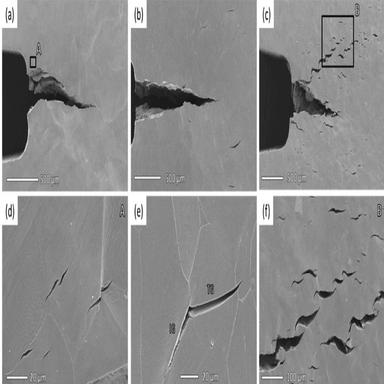
The SEM images obtained by the intermediate side surface examination revealing the primary – (a–c) and secondary – (d–f) cracks in pure iron – (a, d), Fe-2.5%Si alloy – (b, e) and low-carbon steel S235JR – (c, f) after the first-step tensile testing. The magnified images of the areas outlined by latter-labelled frames "A" and "B" in images (a) and (c) are represented in (d) and (f), respectively.